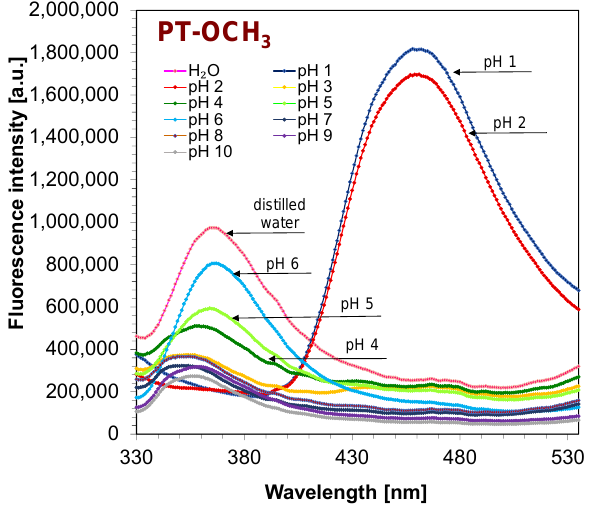
Figure 11. Comparison of fluorescence spectrum maximum location for compound PT-OCH 3 in acetonitrile and pH in a range of 1 – 10.